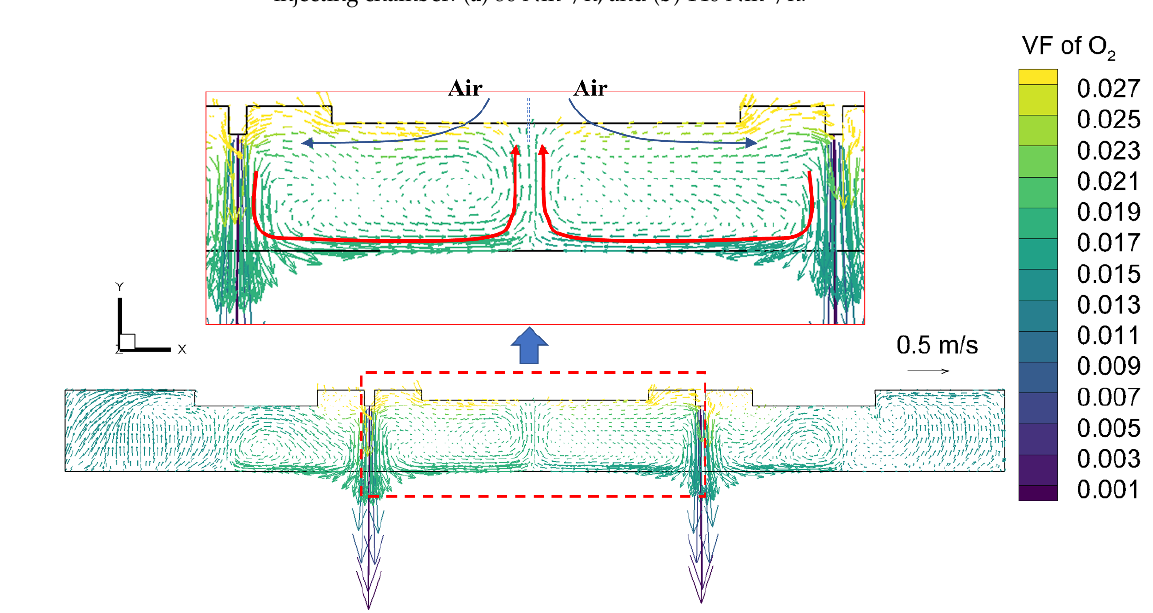
Figure 10. Vector of argon velocity at z = 0 m section in the injecting chamber.